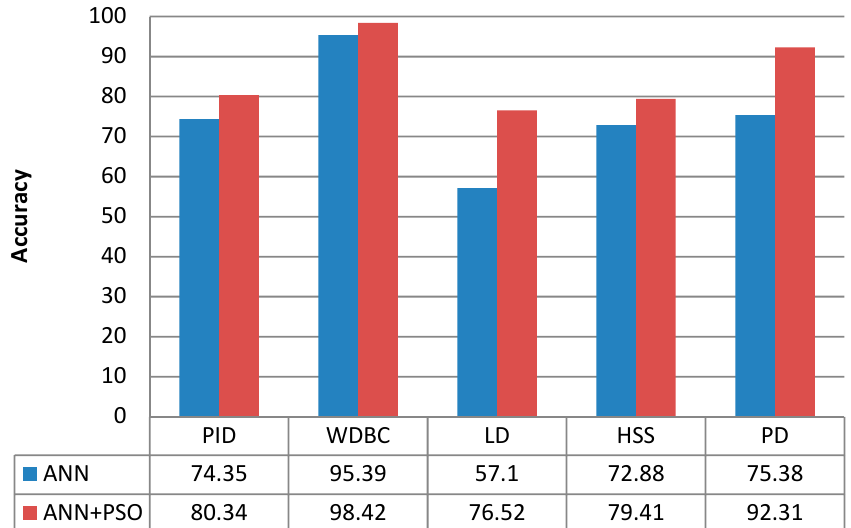
Figure 7. Bar charts show accuracy enhancement of experiment 2.